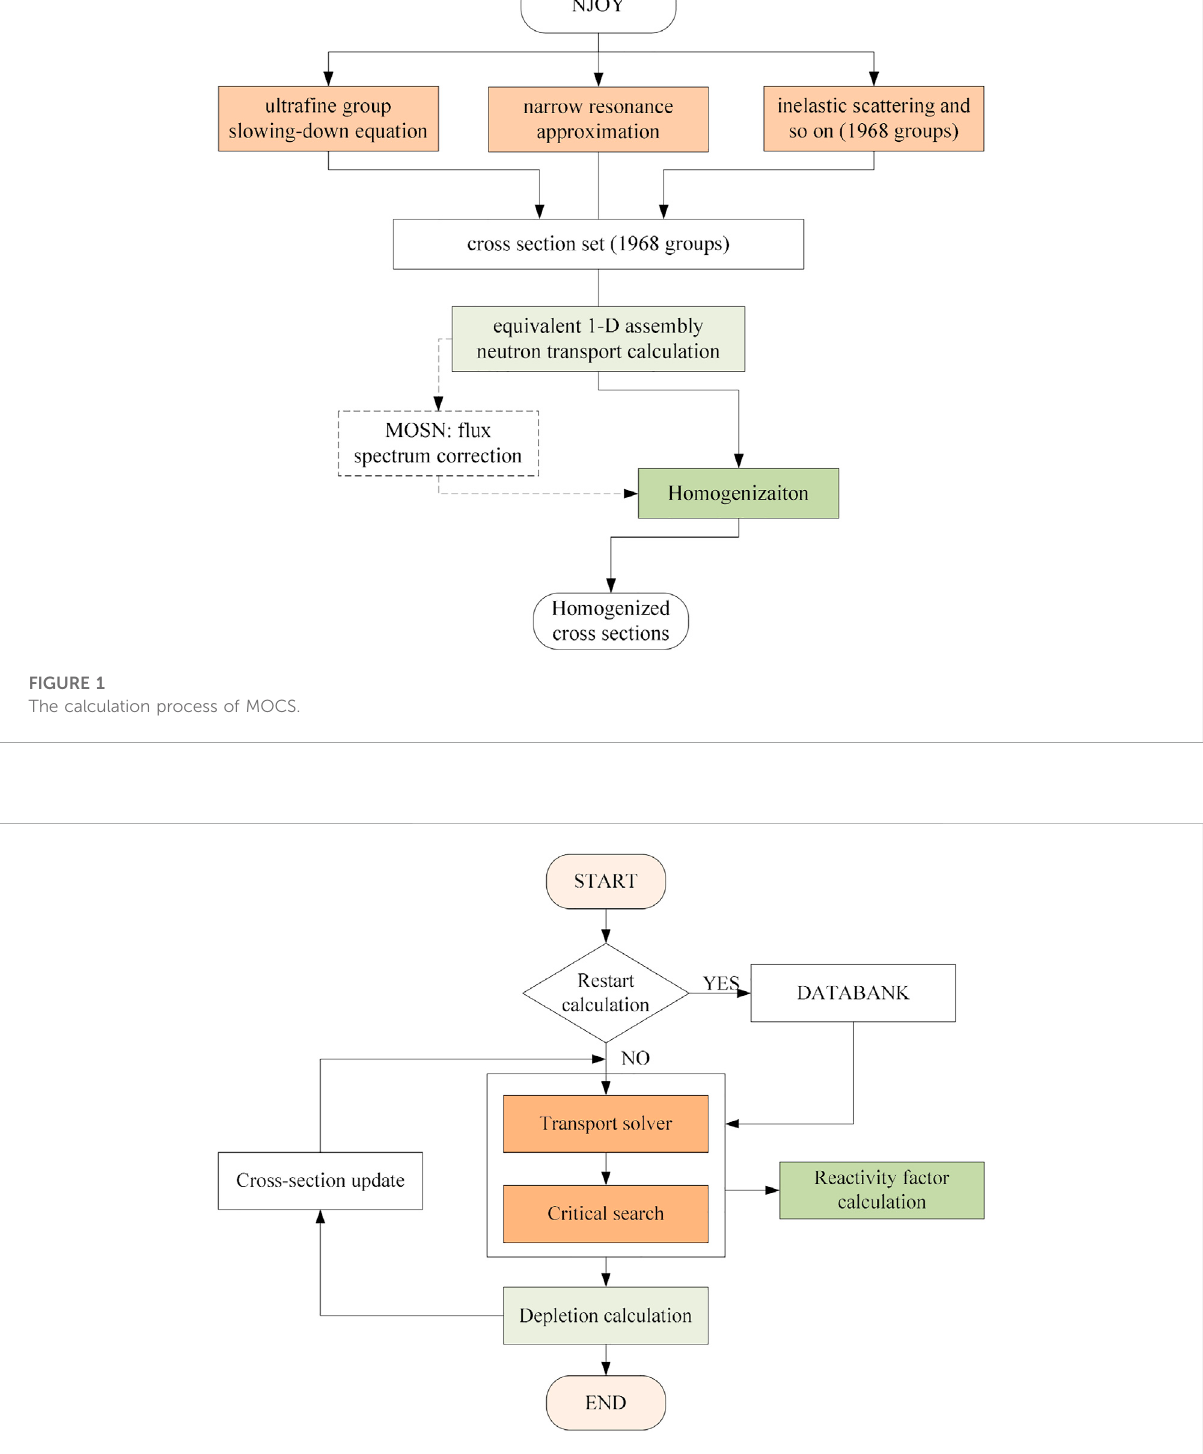
FIGURE 2 The calculation process of